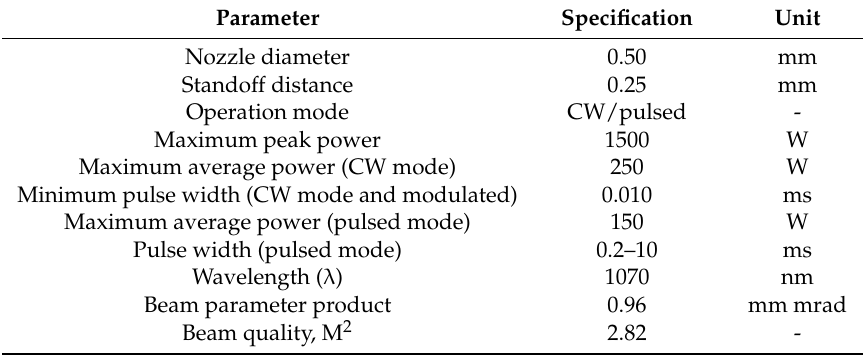
Table 2. Fiber laser system specifications.